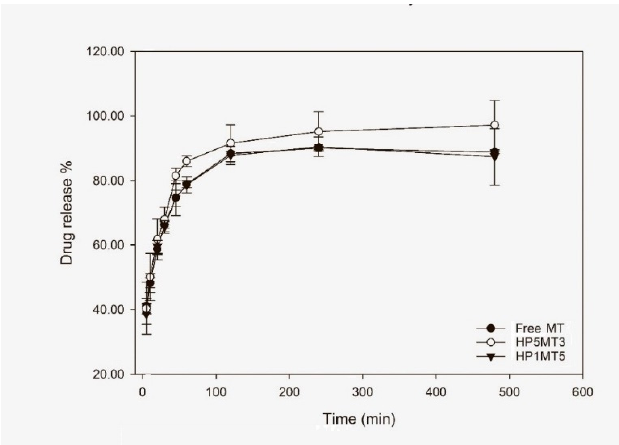
Figure 7. Graphical representation of the means and standard deviations of the results of the release test.